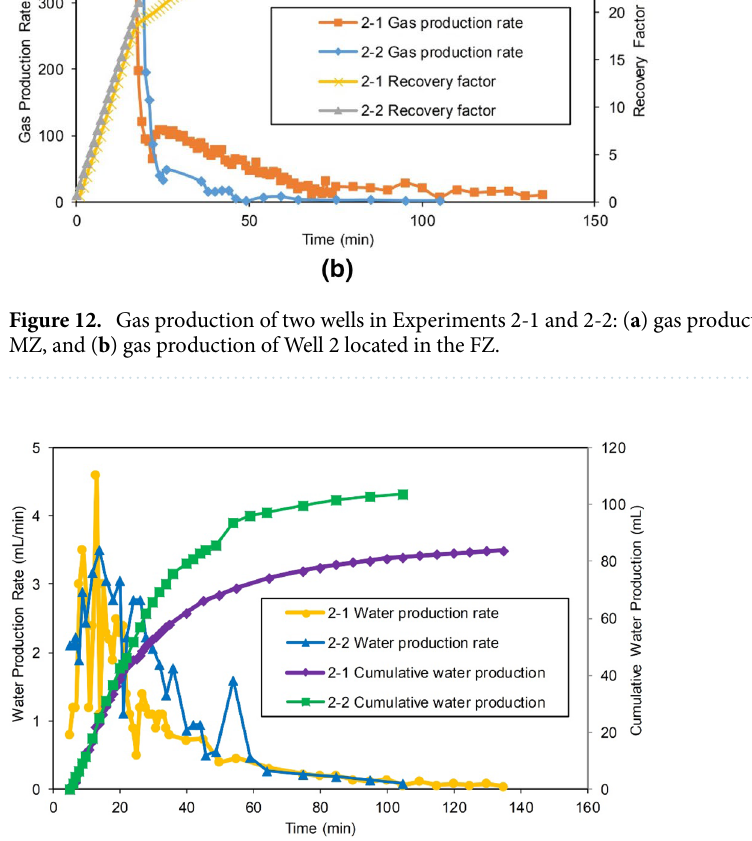
Figure 13. Water productions of Well 2 in Experiments 2-1 and